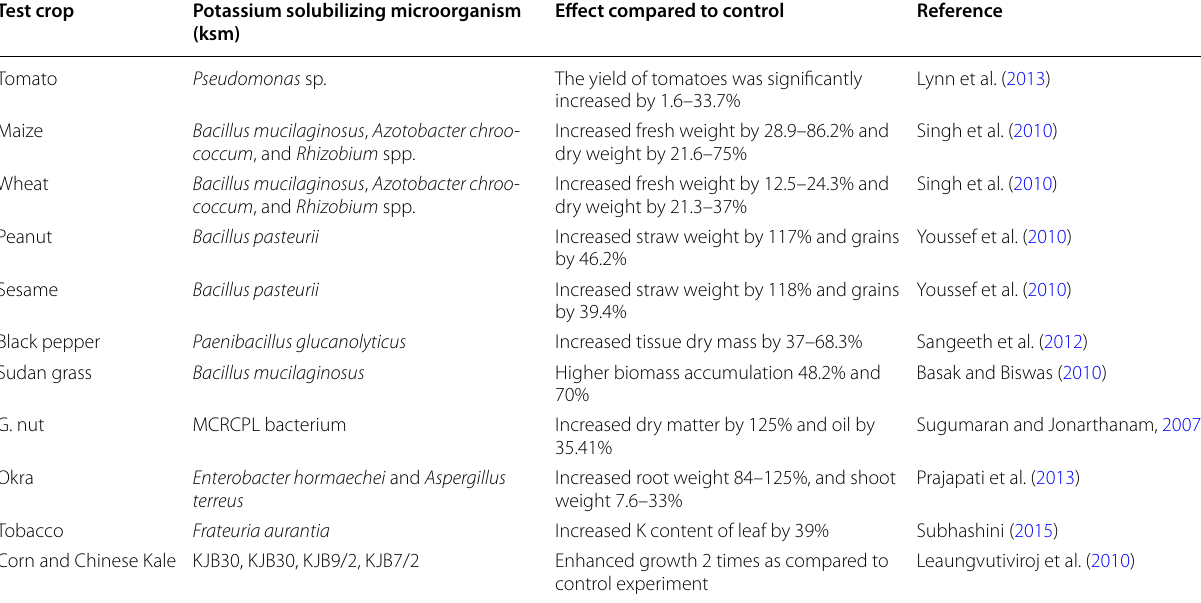
Table 2 Effect of potassium solubilizing microorganisms on crop growth and yield Test